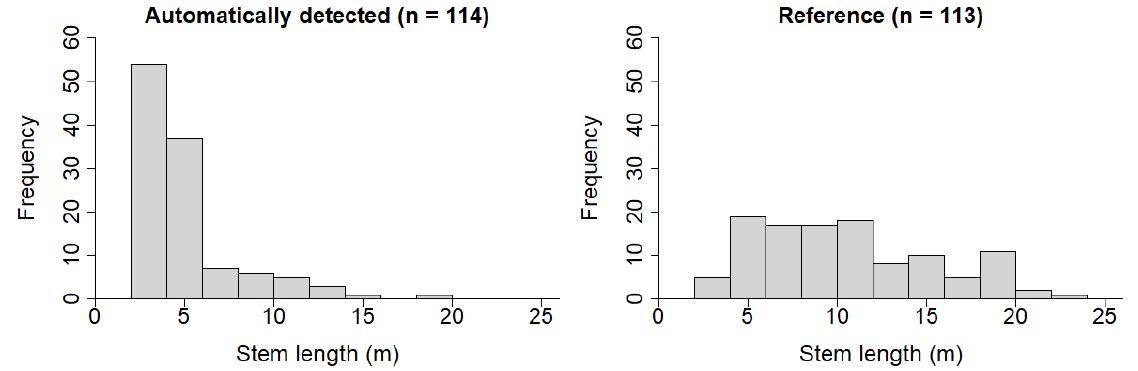
Figure 10. Distribution of the stem lengths on sample site Frohn_02.